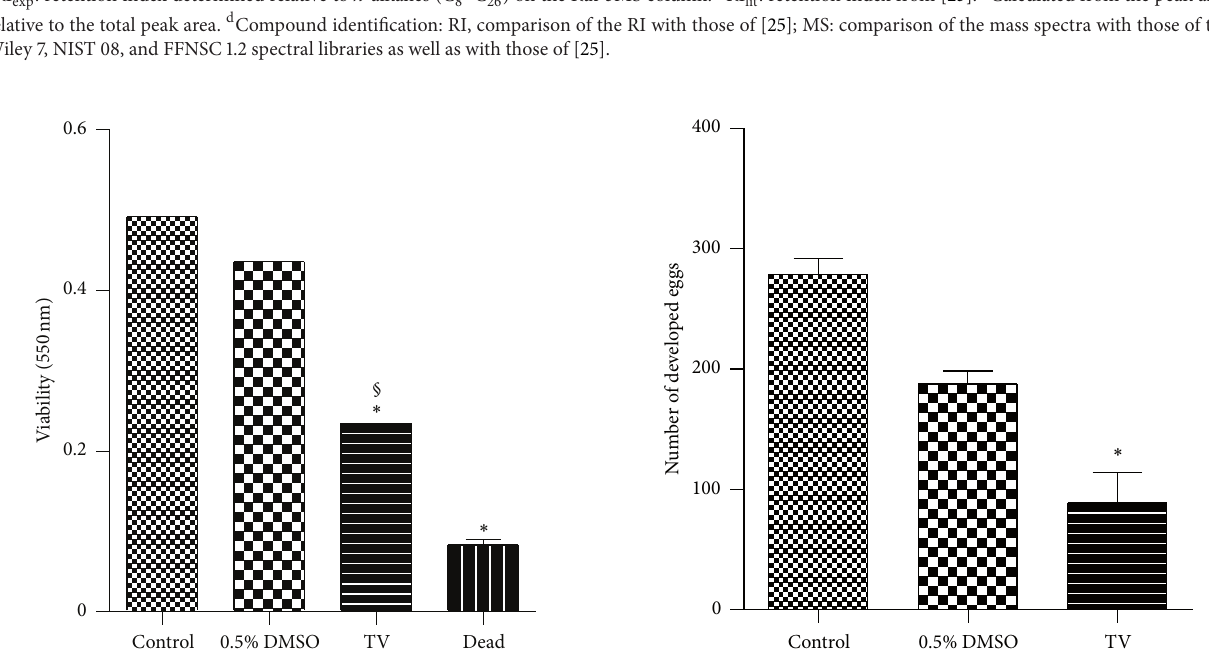
Figure 3: In vitro effect of the crude hydroalcoholic extract of T. vulgare (TV) at 200 𝜇 g/mL on egg development (quantitative analysis of the development phenotype). After treatment, the eggs were microscopically examined and scored as developed or unde- veloped based on the presence or absence of the miracidium. Data are presented as the mean of developed eggs from two separate experiments. ∗ Significantly different from control ( 𝑃 < 0.05